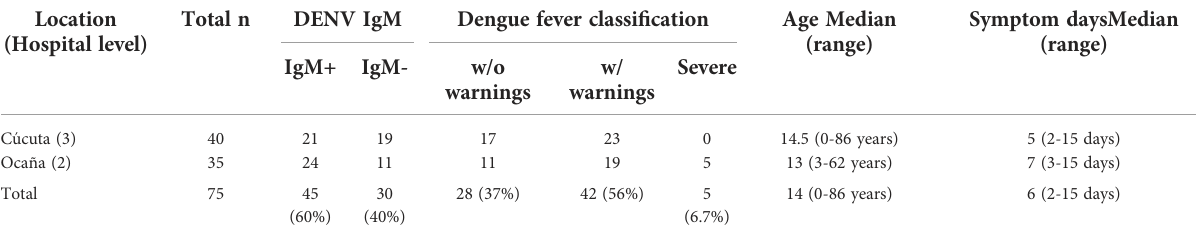
TABLE 1 Cohort characteristics by hospital level.